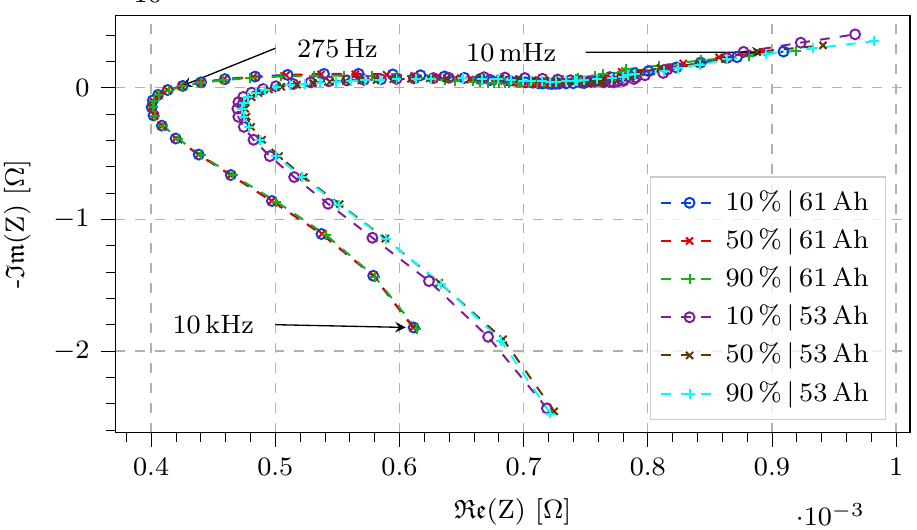
Figure 1. Nyquist plot of cell C1’s impedance at beginning of life and after 13 months. Measurements performed at 25°C and 3 SoC levels. In the legend, left column represents SoC when impedance was measured, while right one is the measured maximum available